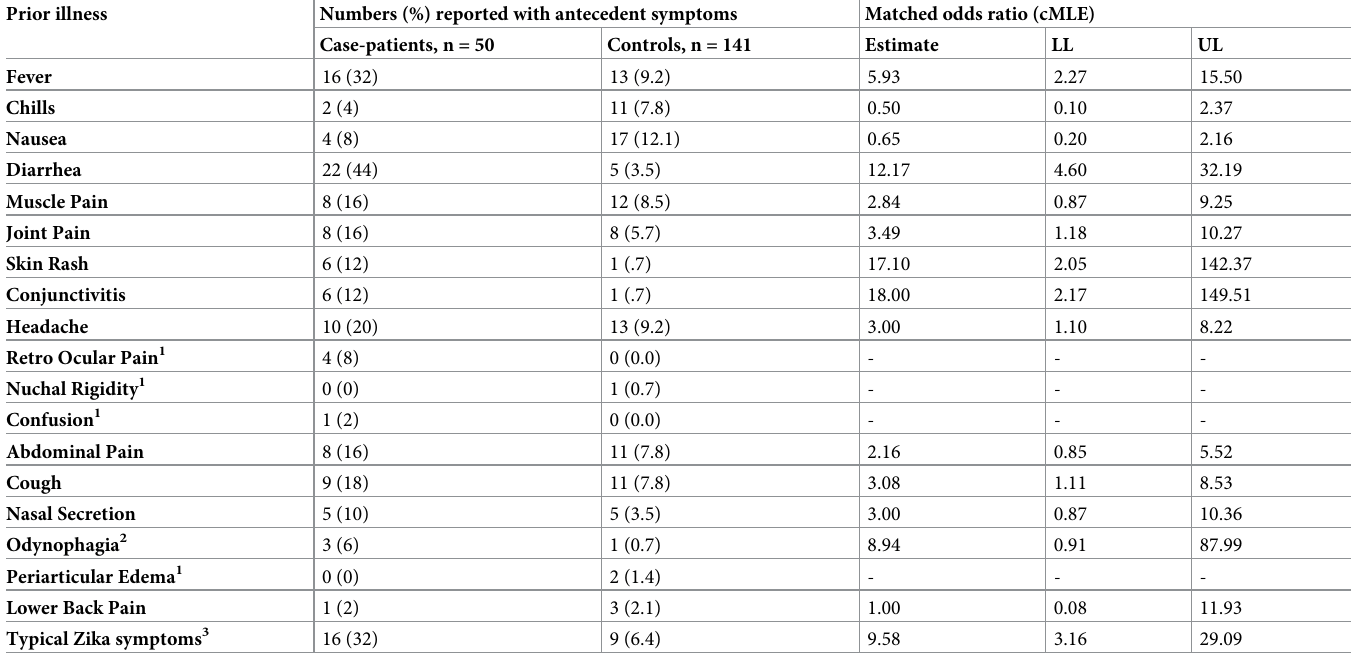
Table 4. Association between prior illness and GBS for 50 GBS case-patients and 141 matched controls–clinical symptoms reported prior to neurological onset/ interview and virus infection. Prior